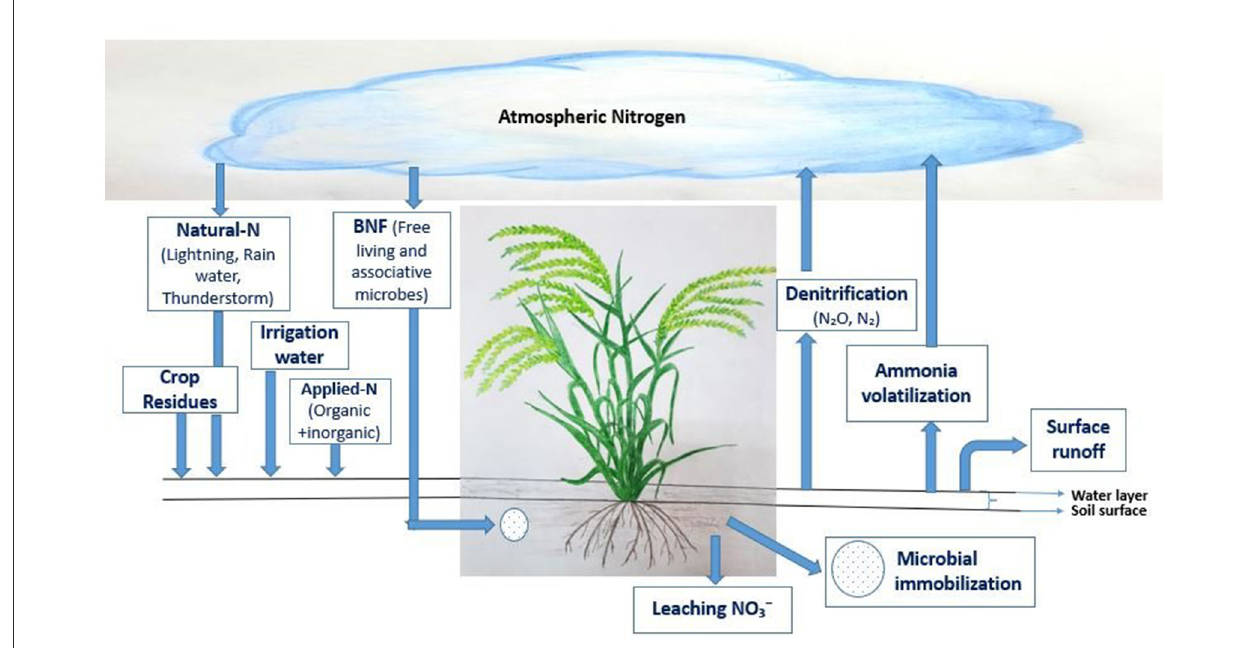
FIGURE1 Sources and losses of nitrogen (N) in wetland rice